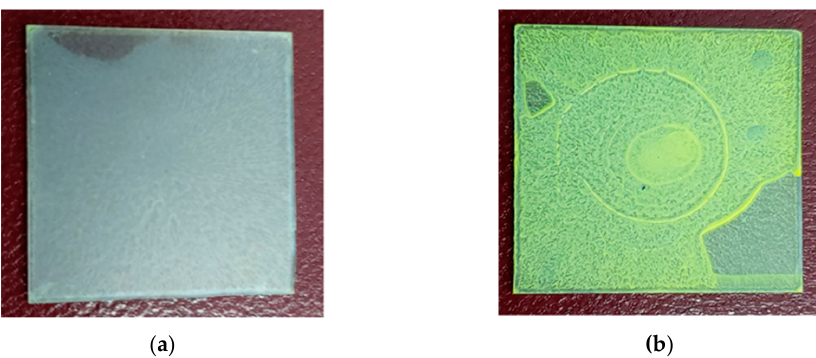
Figure 1. Photos of the two thin films samples (2.54 × 2.54 cm) prepared by spin coating and annealing at 560 °C: ( a ) sample prepared with bismuth nitrate; ( b ) sample prepared with bismuth acetate.